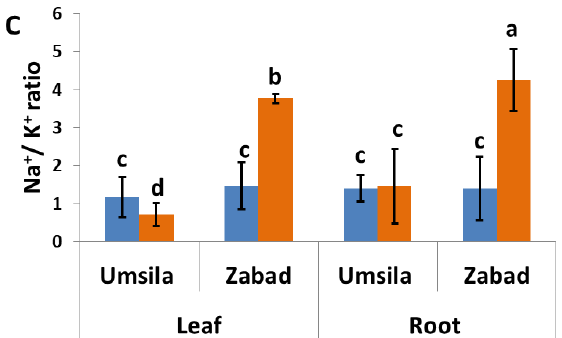
Figure 3. The effect of salinity on sodium (Na + ) ( A ) and potassium (K + ) ( B ) accumulation and on the Na + /K + ratio ( C ) in date palm seedlings when subjected to control (0 mM NaCl) and salinity (240 mM NaCl) conditions. Bars represent the mean ± SE ( n = 3).